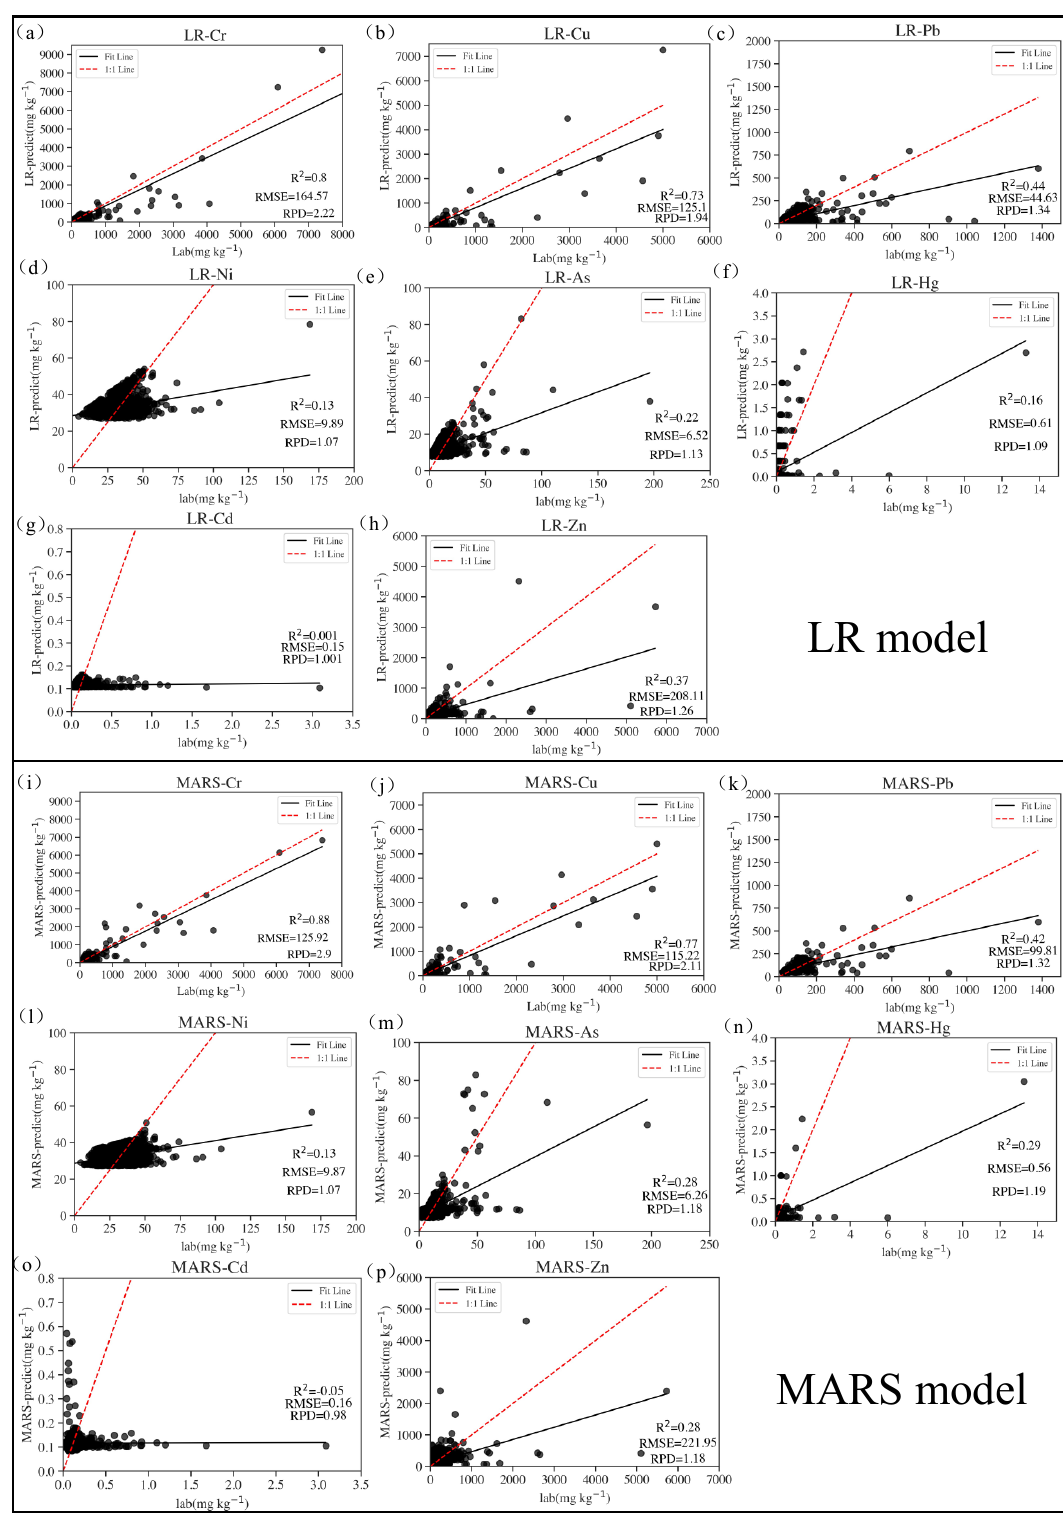
Figure 2. Concentrations of heavy metals predicted from each pXRF measurement using LR and MARS models against laboratory concentrations of the whole dataset. The red dashed line is the 1:1 line, the black line is the regression line, and the points are semi-transparent to show point density. ( a – h ) Prediction results of LR models. ( i – p ) Prediction results of MARS model.3.2.2. Predictive results of samples in pXRF high-value and low-value datasets.